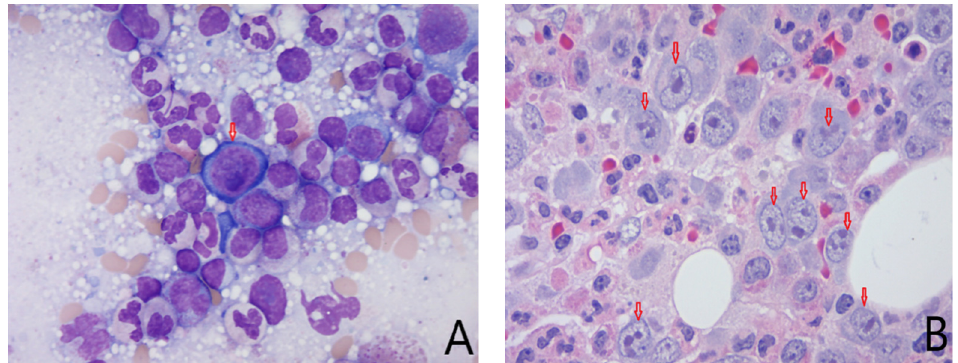
Figure 1. Images from the patient’s bone marrow biopsy samples: ( A ) Bone marrow aspirate. Arrow shows a proerythroblast with possible viral inclusion (difficult to distinguish from unusually large nucleoli). ( B ) Bone marrow trephine: Erythroid cells (arrows) are decreased in number and severely left-shifted with nearly complete arrest at the pro-erythroblast stage.